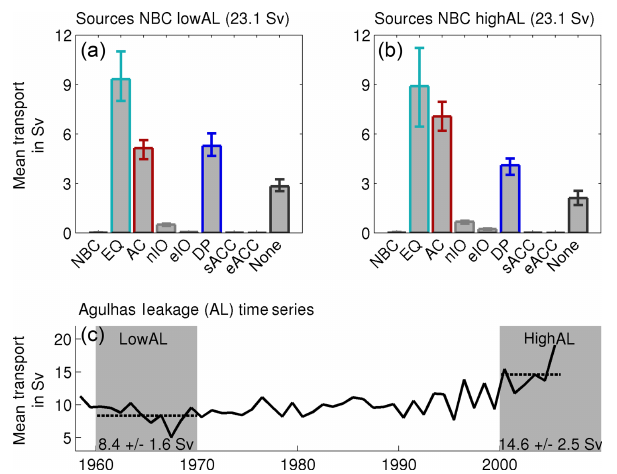
Figure 12. Sensitivity of NBC sources to the strength of Agul- has leakage (AL): mean volumetric contributions of the individual sources to the NBC inferred from (a) lowAL and (b) highAL (see Fig. 3); (c) interannual variability of AL transport as derived by Schwarzkopf et al. (2019, see Appendix A).